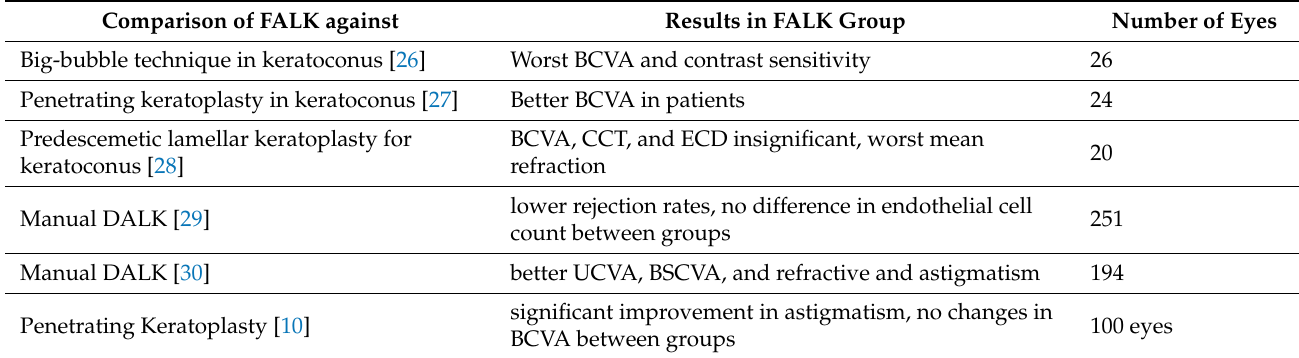
Table 4. Comparison of results of